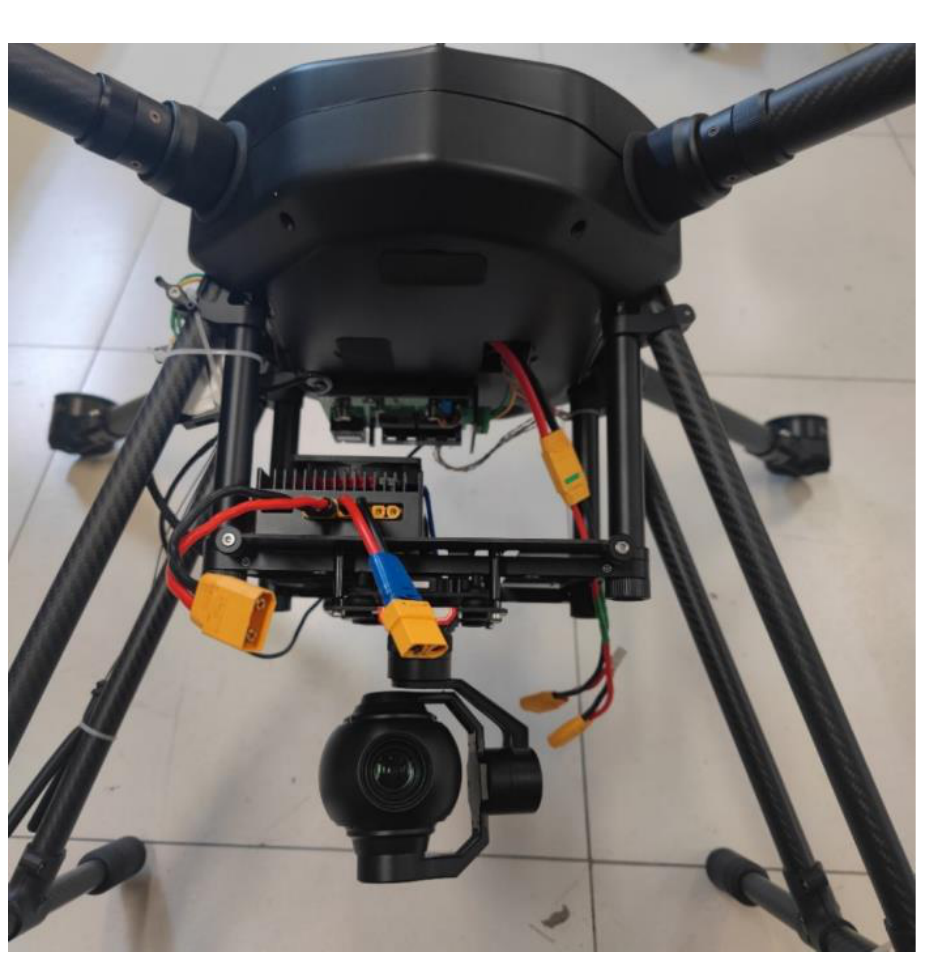
Figure 6. Pan – tilt – zoom camera (mounted under the UAV). Figure 6. Pan–tilt–zoom camera (mounted under the